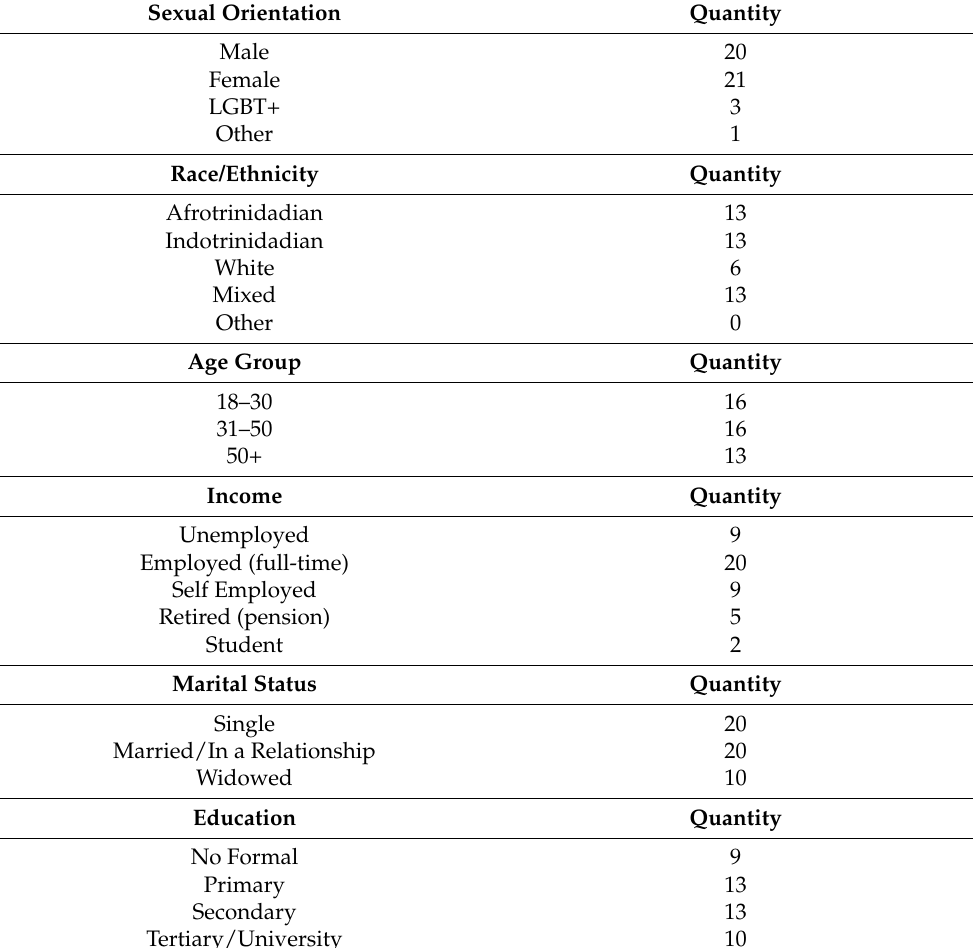
Table 1. Demographics of